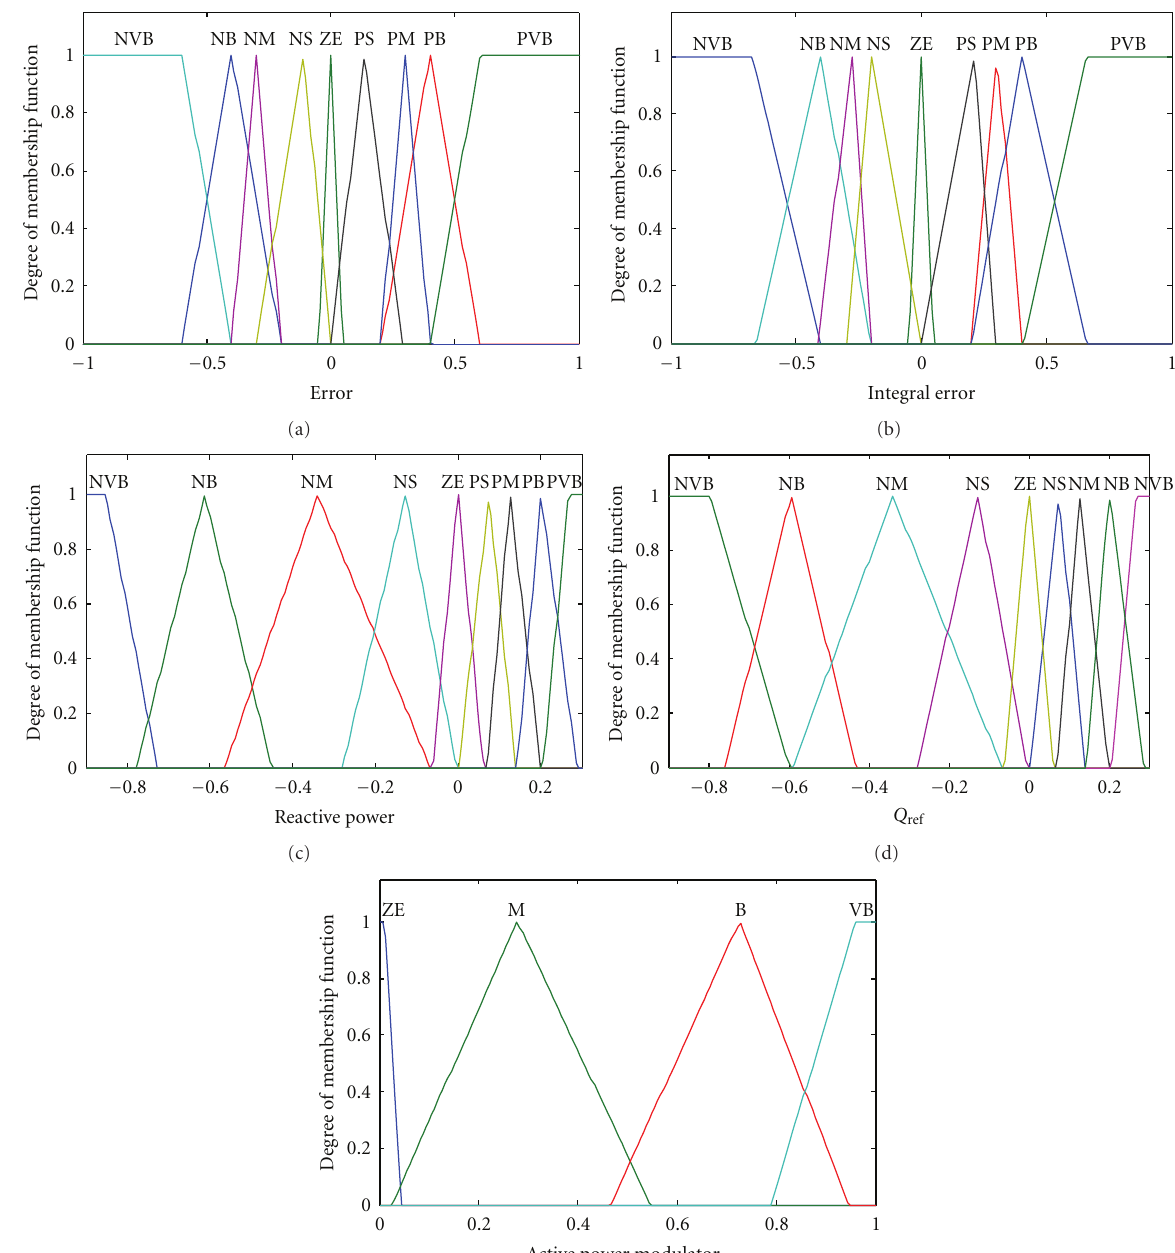
Figure 3: Membership functions of fuzzy controller. (a) Input signal error, (b) input signal integral error, (c) input signal reactive power measured at the PCC, (d) output reference reactive power, and (e) output active power